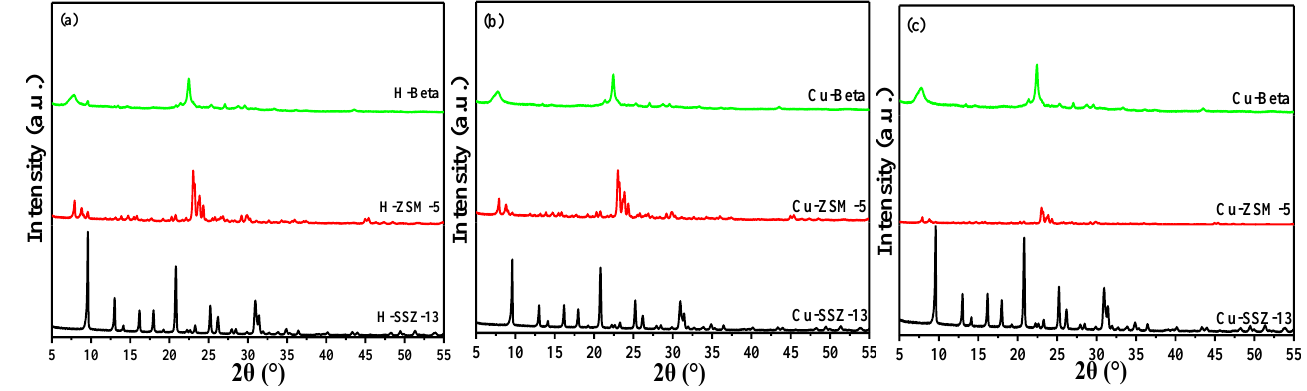
Figure 2. XRD patterns of zeolite supports ( a ), copper-based catalysts ( b ) and copper-based zeolites after the NH 3 -SCR reaction ( c ).